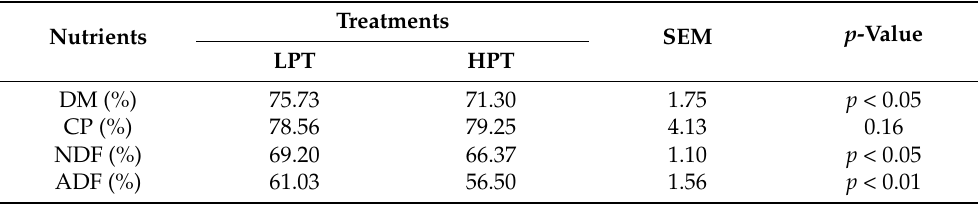
Table 4. Effect of low and high NFC to NDF ratio pelleted TMR on nutrient apparent digestibility in Holstein growing